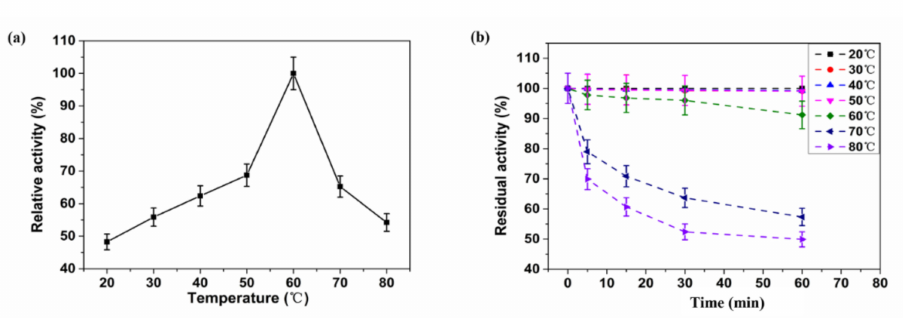
Figure 5. Effects of temperature on enzyme activity and stability of XynST7: ( a ) optimum temperature of XynST, ( b ) thermostability of